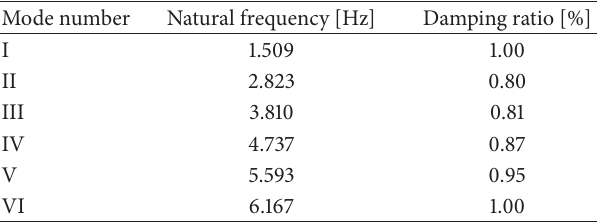
Table 1: Modal properties of the simulated 6-DOF